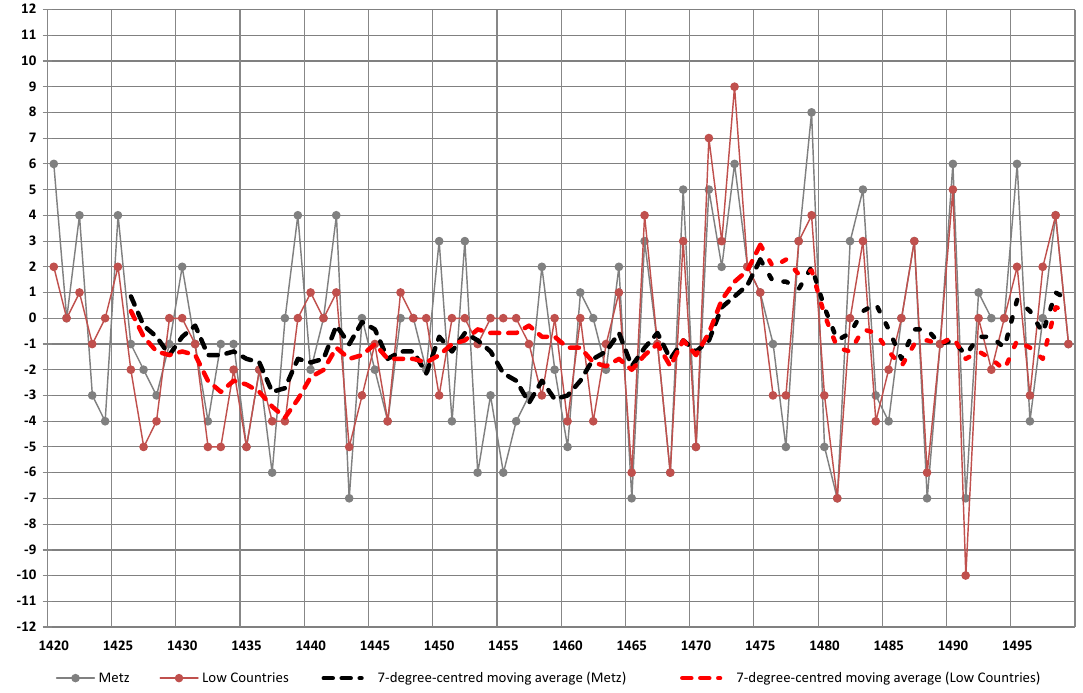
Figure 8. Comparison between temperature indices from Metz (Litzenburger, 2015) and the Low Countries (Camenisch,